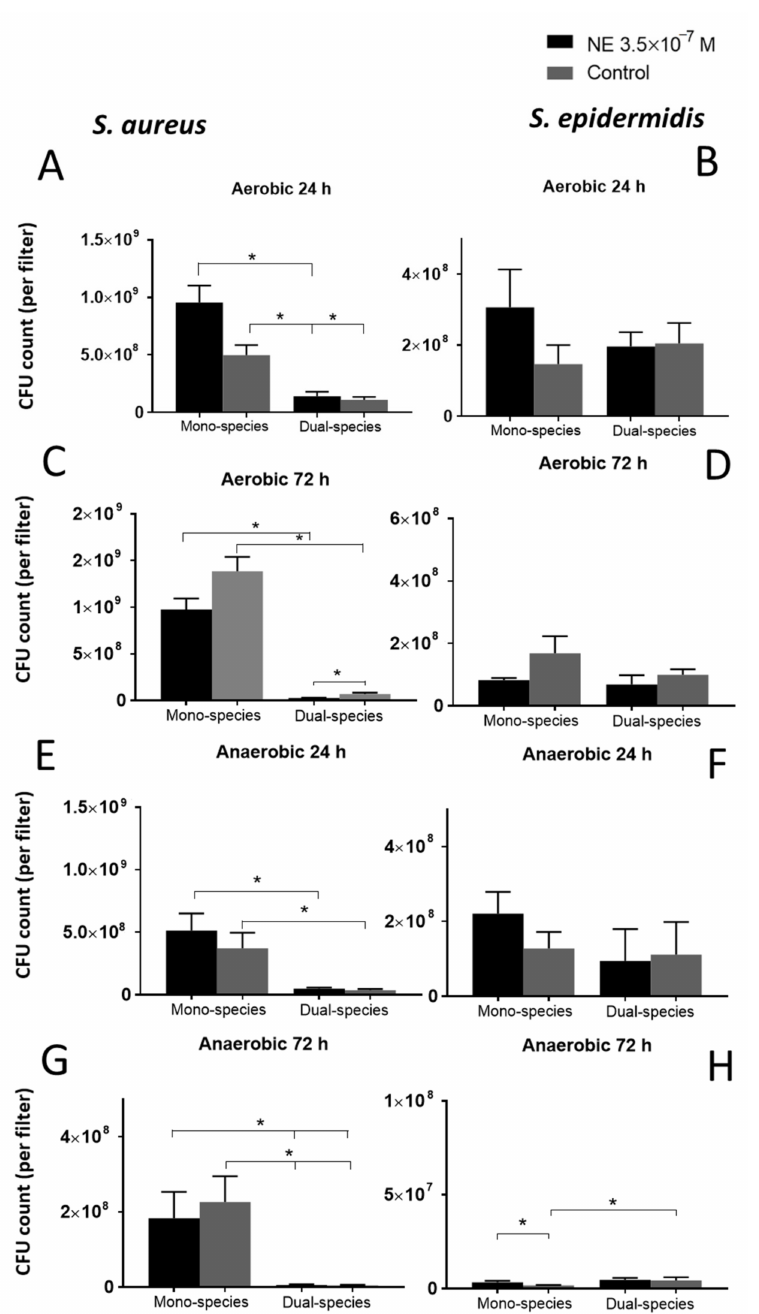
Figure 2. Total CFU count of S. aureus ( A , C , E , G ) and S. epidermidis ( B , D , F , H ) per filter in studied biofilms under aerobic ( A – D ) and anaerobic ( E – H ) conditions after 24 h ( A , B , E , F ) and 72 h ( C , D , G , H ) of incubation. Mean values are indicated, and error bars represent standard error of the mean, *— p < 0.05 according to Mann-Whitney